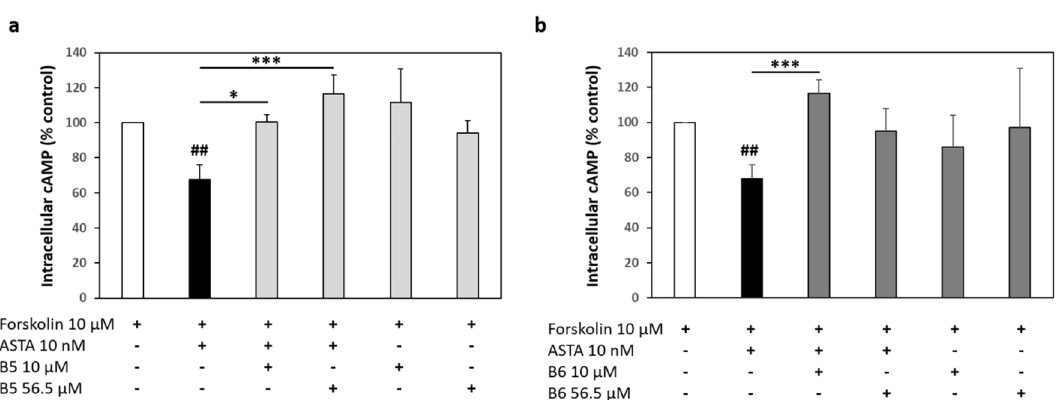
Figure 8. Effects of B5 and B6 compounds on ASTA signaling in vitro. Relative levels of forskolin-induced intracellular cAMP (expressed as percentages of control levels, i.e. with forskolin only). Treatment with ASTA significantly decreased cAMP levels, which was reversed when either B5 ( a ) or B6 ( b ) was added (albeit not significantly with 56.5 μM B6). ##: p < 0.01 (vs. forskolin only); *: p < 0.05; ***: p < 0.0005 (vs. forskolin + ASTA) (at least 5 replicates per